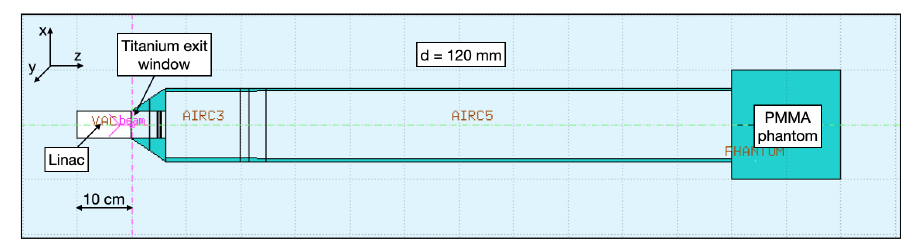
Figure 2. Two-dimensional visualization of FLUKA simulation geometry used for the A-d120 simulation. The beam travels in the z direction.